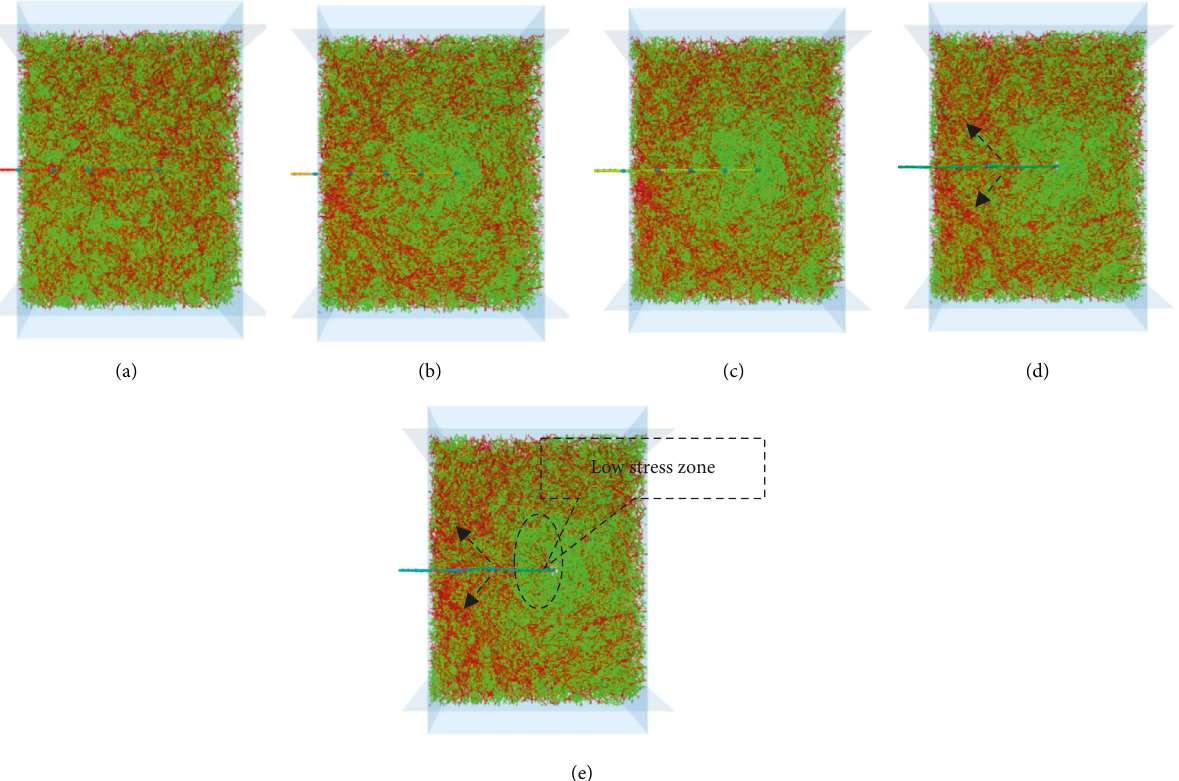
Figure 12: Evolution of the force chain of soil particles under a vertical load of 25kPa. (a) L (d) L 12mm, and (e) L (cid:31)